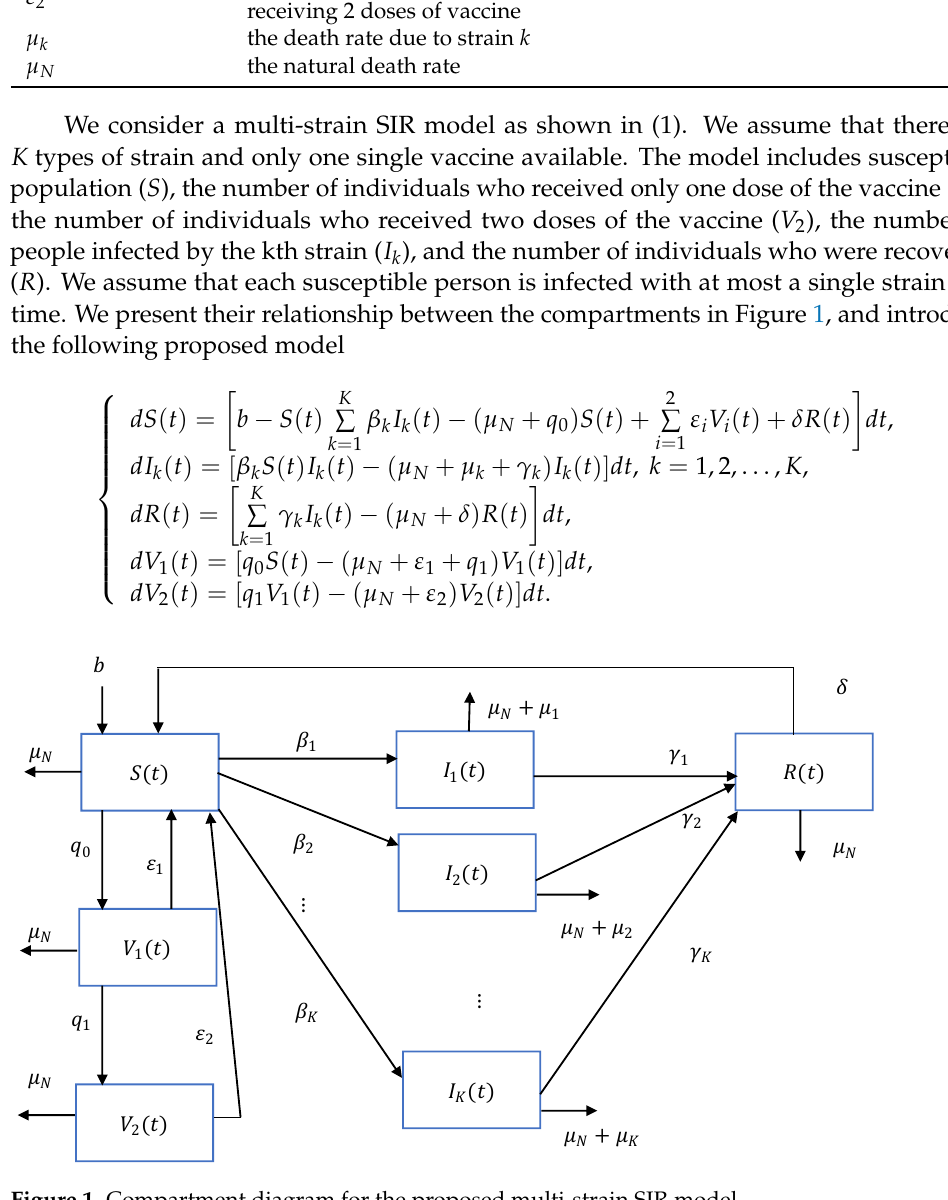
Figure 1. Compartment diagram for the proposed multi-strain SIR model.